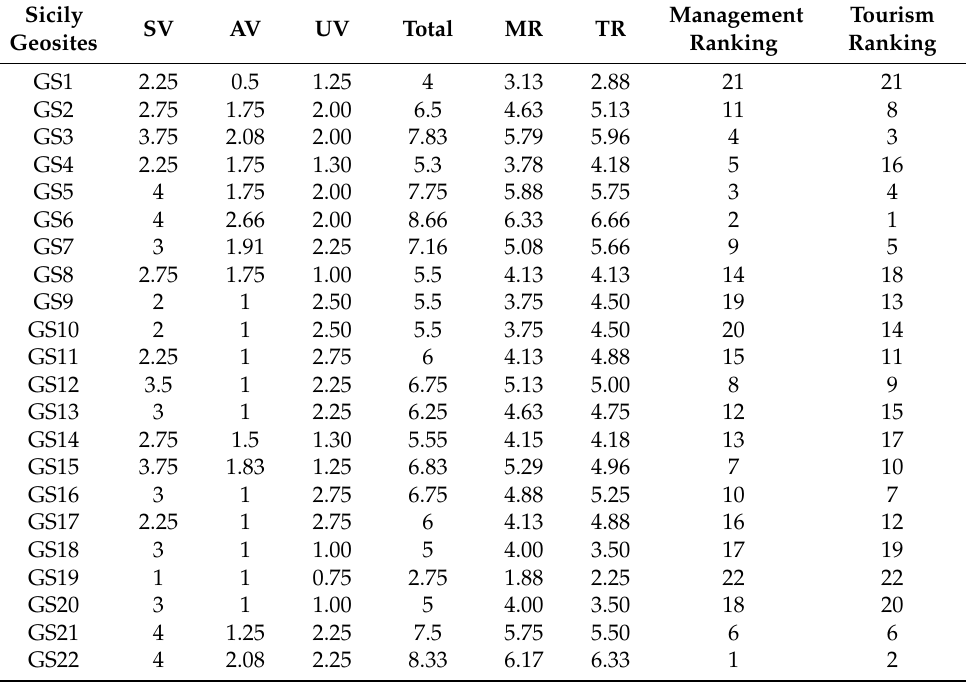
Table 3. General numerical assessment of the 22 sites of the Sicily study area (GEOSIC). Legend: SV, scientific value; AV, additional value; UV, use value; MR, management rating; TR, tourism